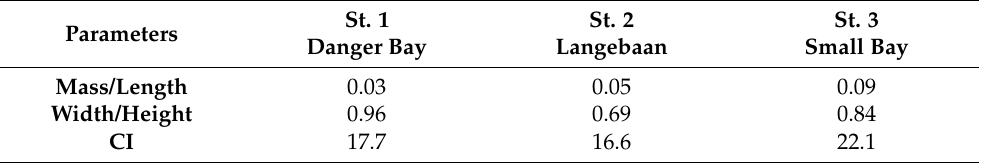
Table 5. Morphometry ratios in mussel samples from 3 stations of Saldanha Bay. St. Parameters